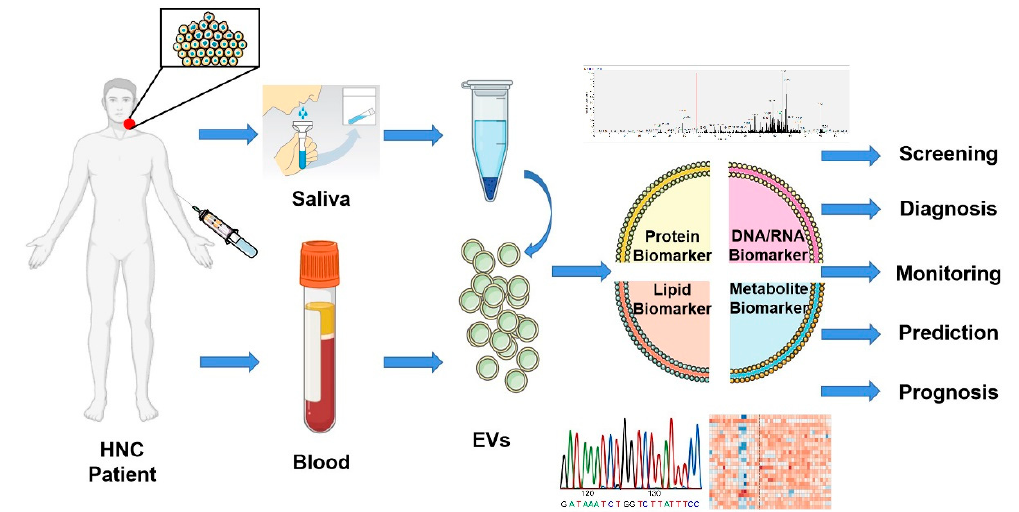
Figure 4. Biomarker potential of extracellular vesicles. Liquid biopsies based on EVs offer a promising non-invasive method for screening, diagnosis, monitoring, prediction, and prognosis of head and neck cancer patients. EVs isolated from saliva or blood can be analyzed through multi-omics studies